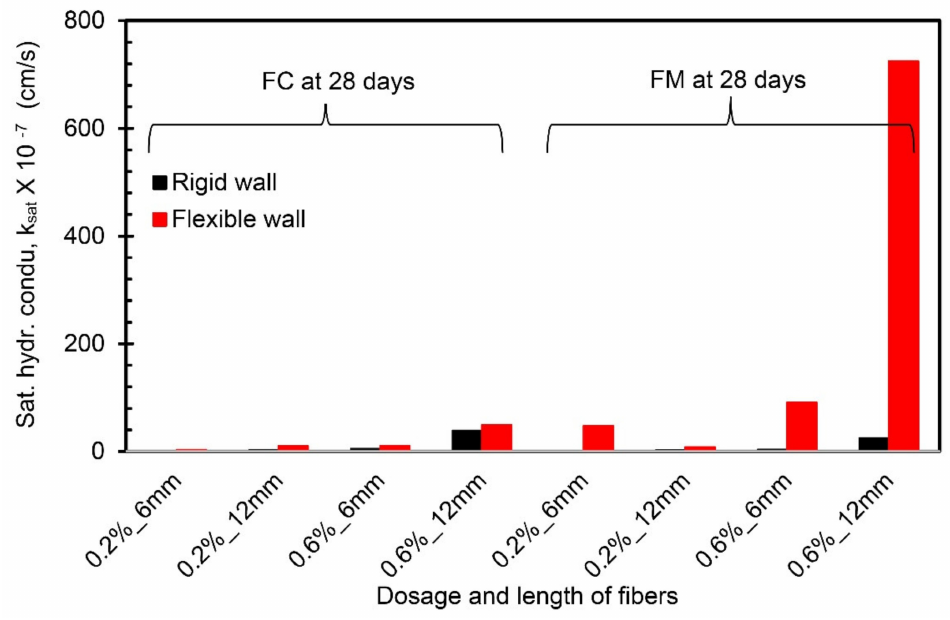
Figure 11. Comparison of hydraulic conductivity values from FWP and RWP (28-day curing